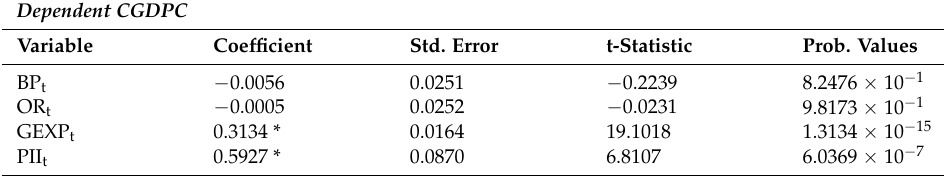
Table 7. Constant GDP per capita, long-run